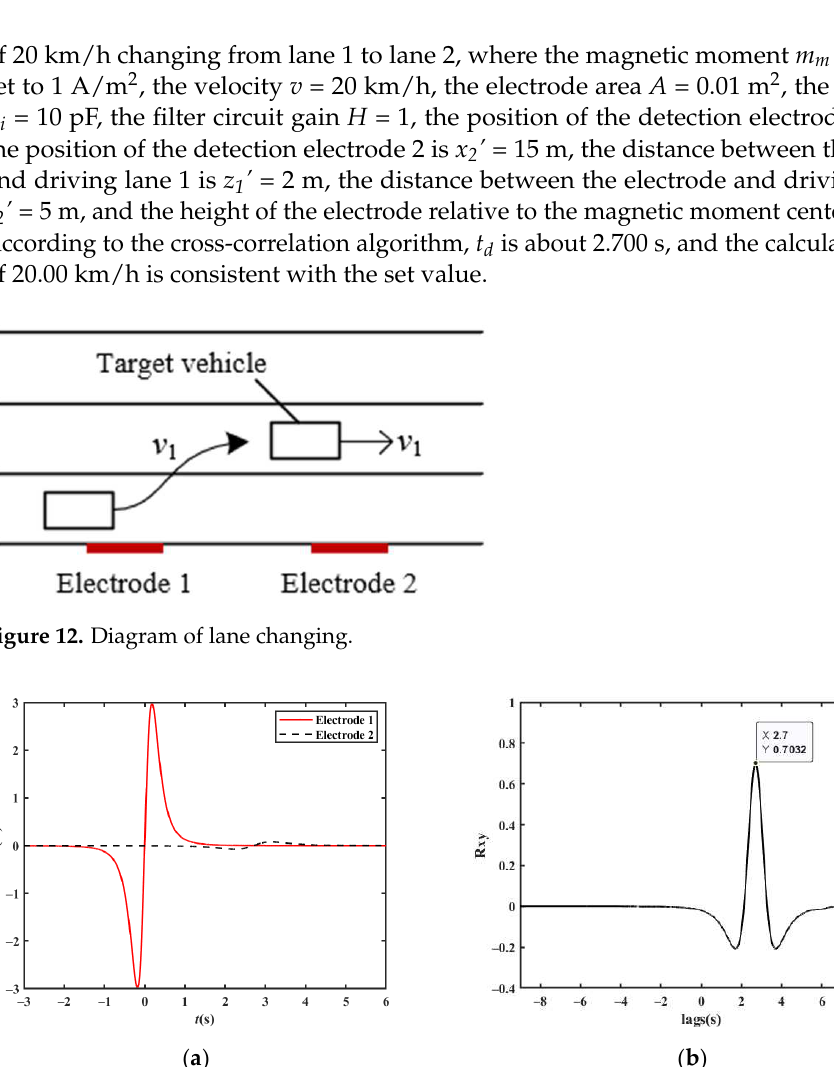
10 of 19 Figure 11. Simulation results of a single vehicle passing by two electrodes: ( a ) simulation results at a velocity of 20 km/h; ( b ) cross-correlation results at a velocity of 20 km/h; ( c ) simulation results at a velocity of 90 km/h; ( d ) cross-correlation results at a velocity of 90 km/h; ( e ) simulation results at